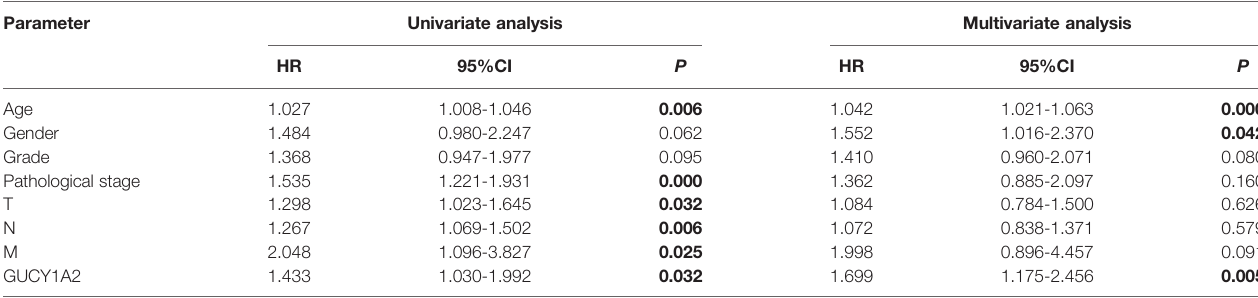
TABLE 2 | Univariate and multivariate analysis of prognostic factors in GC